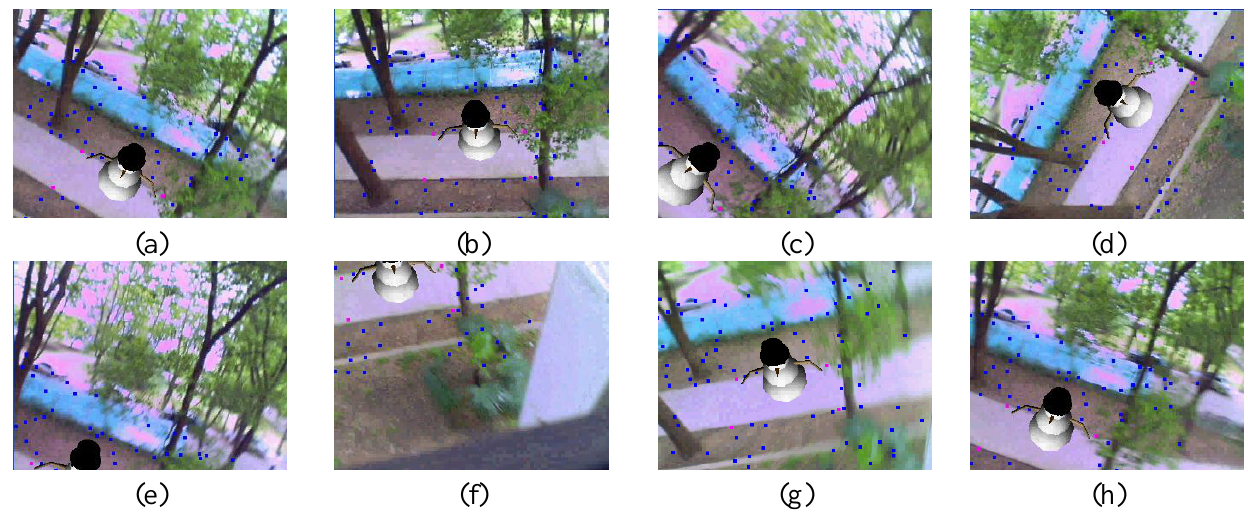
Figure 7. Results of the outdoor